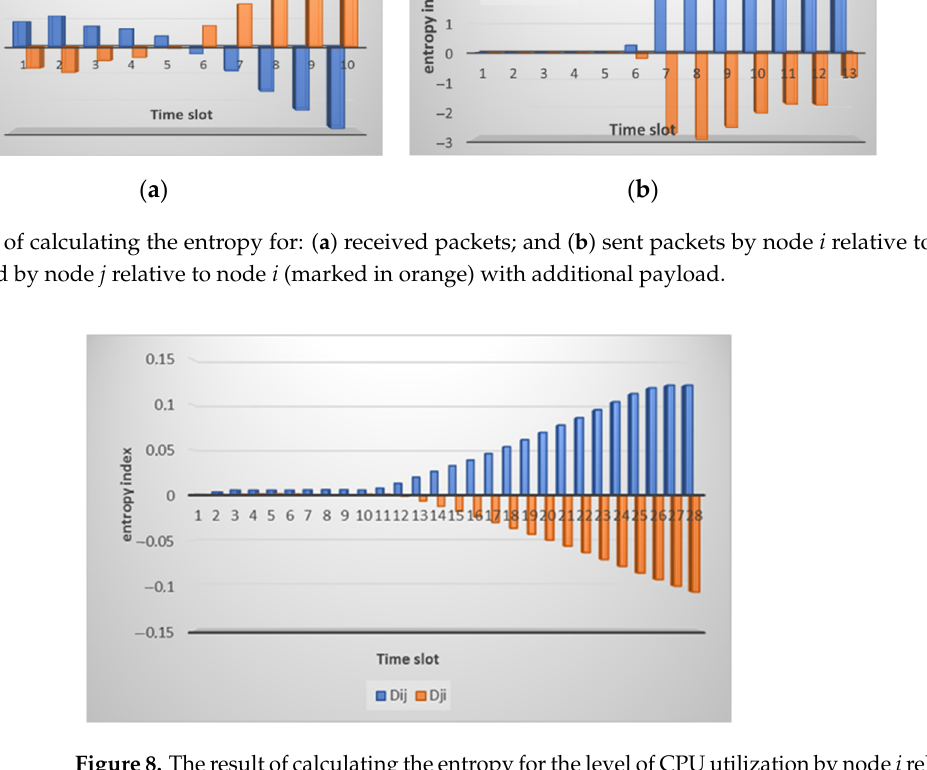
Figure 8. The result of calculating the entropy for the level of CPU utilization by node i relative to node j (marked in blue) and by node j relative to node i (marked in orange) with an additional payload.